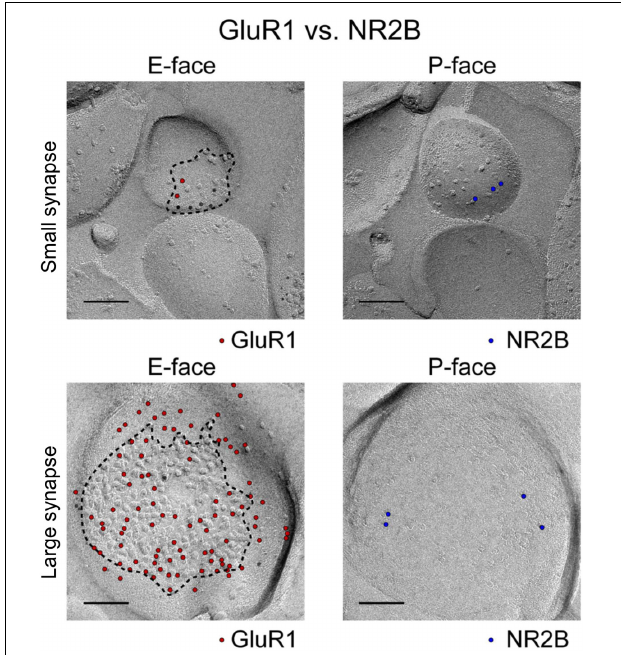
FIGURE 2 | Image and legend reprinted from Shinohara and Hirase (2009). Examples of paired SDS-digested freeze-fracture replica labeling (SDS-FRL) for GluR1 (E-face) vs. NR2B (P-face) in CA1 stratum radiatum synapses (old nomenclature for glutamate receptors is used). Upper rows are examples of small synapses, whereas lower rows are that of large synapses. Boundaries of intramembrane particles (IMP) shown in dotted lines in E-faces correspond to exposed PSD areas (ePSD). Scale bars: 100